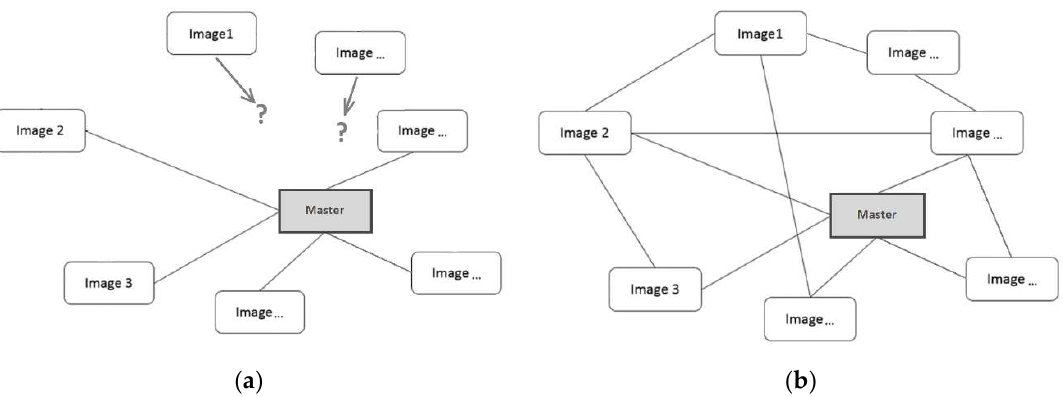
Figure 1. Traditional ‘master-to-slave’ ( a ) versus multi-image alignment ( b ). Lines represent the existence of enough corresponding features shared between two images to enable the computation of the registration parameters.